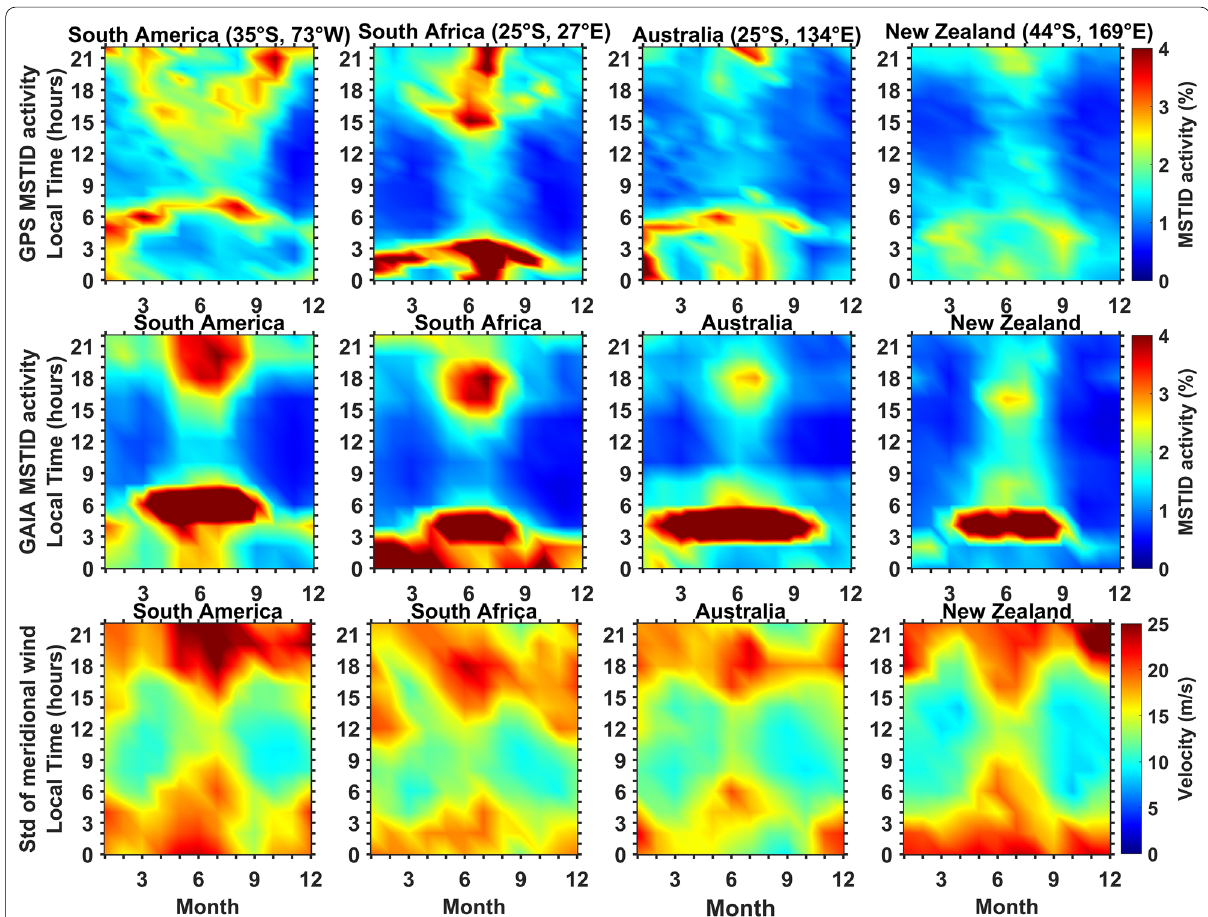
Fig. 4 Same as Fig. 2, but for different location in the southern hemisphere viz., South America, South Africa, Australia and New Zealand in